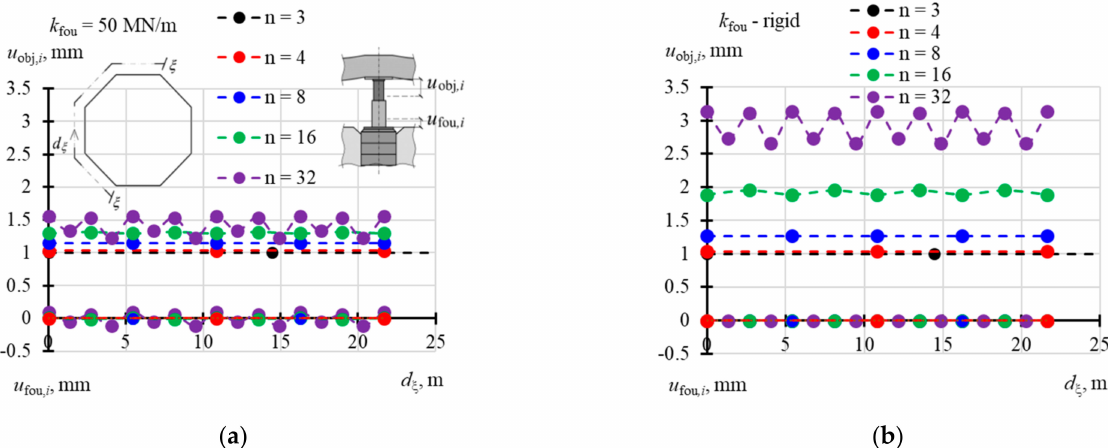
Figure 25. Displacements of the object at points i ( u obj, i ) and displacements of the support of the i -th jack ( u fou, i ) after forced extensions of all the jack pistons u ext, j = 1 mm ( j = 1, . . . , n ): ( a ) k fou = 50 MN/m; ( b ) rigid support for the